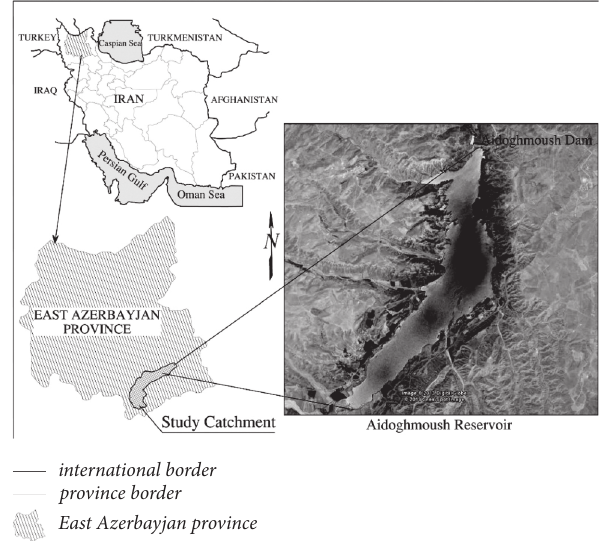
Figure 8: Location of the case study